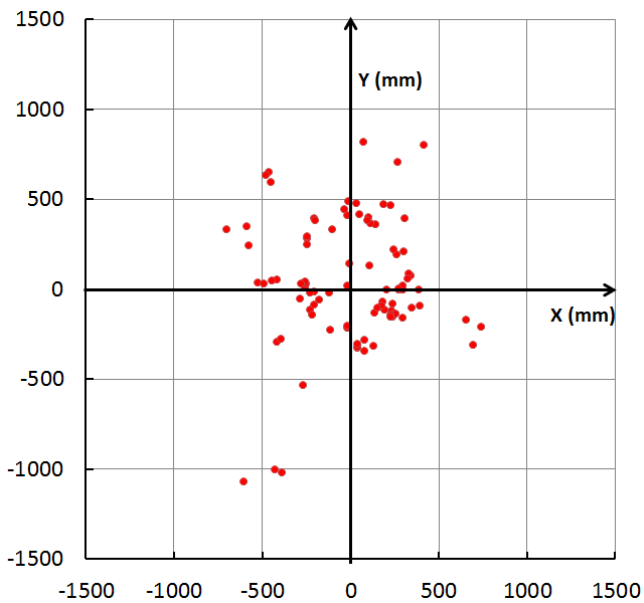
Figure 5. Distribution of the estimation error of IMES radio-based